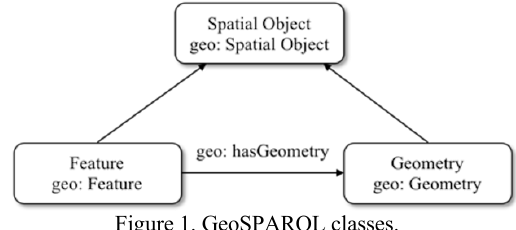
Figure 1. GeoSPARQL classes.